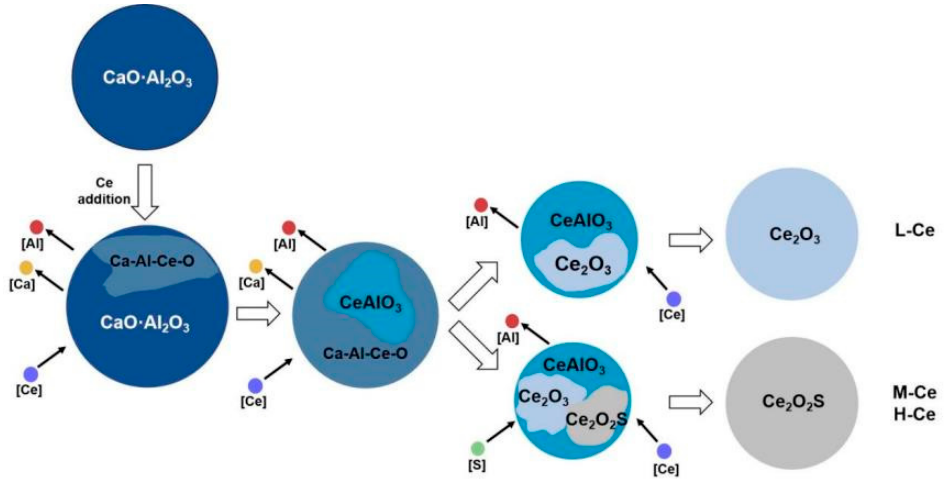
Figure 13. Schematics of modification of Ca–Al–O system inclusions by Ce in C110 steel.